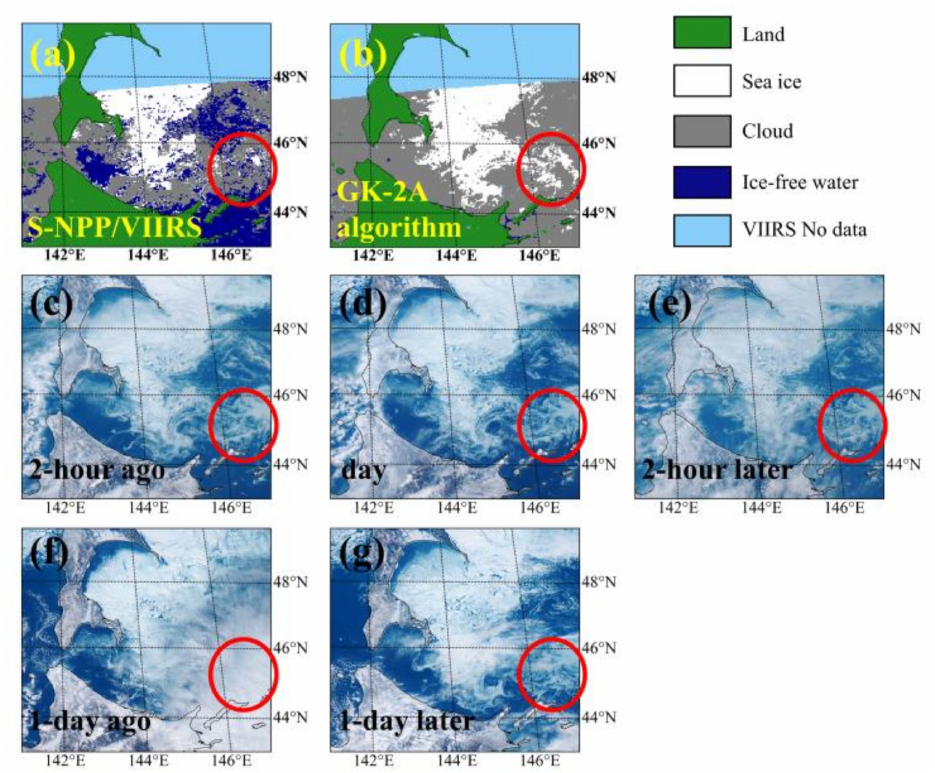
Figure 13. ( a ) S-NPP / VIIRS SIC EDR data at 03:28 UTC, 11 March 2018, ( b ) sea-ice data using GK-2A / AMI sea-ice detection algorithm at 03:30 UTC, 11 March 2018, ( c ) Himawari-8 / AHI RGB images at 01:30 UTC, 11 March 2018, ( d ) Himawari-8 / AHI RGB images at 03:30 UTC, March 2018, ( e ) Himawari-8 / AHI RGB images at 05:30 UTC, 11 March 2018, ( f ) Himawari-8 / AHI RGB images at 03:30 UTC, 10 March 2018 and ( g ) Himawari-8 / AHI RGB images at 03:30 UTC, 12 March